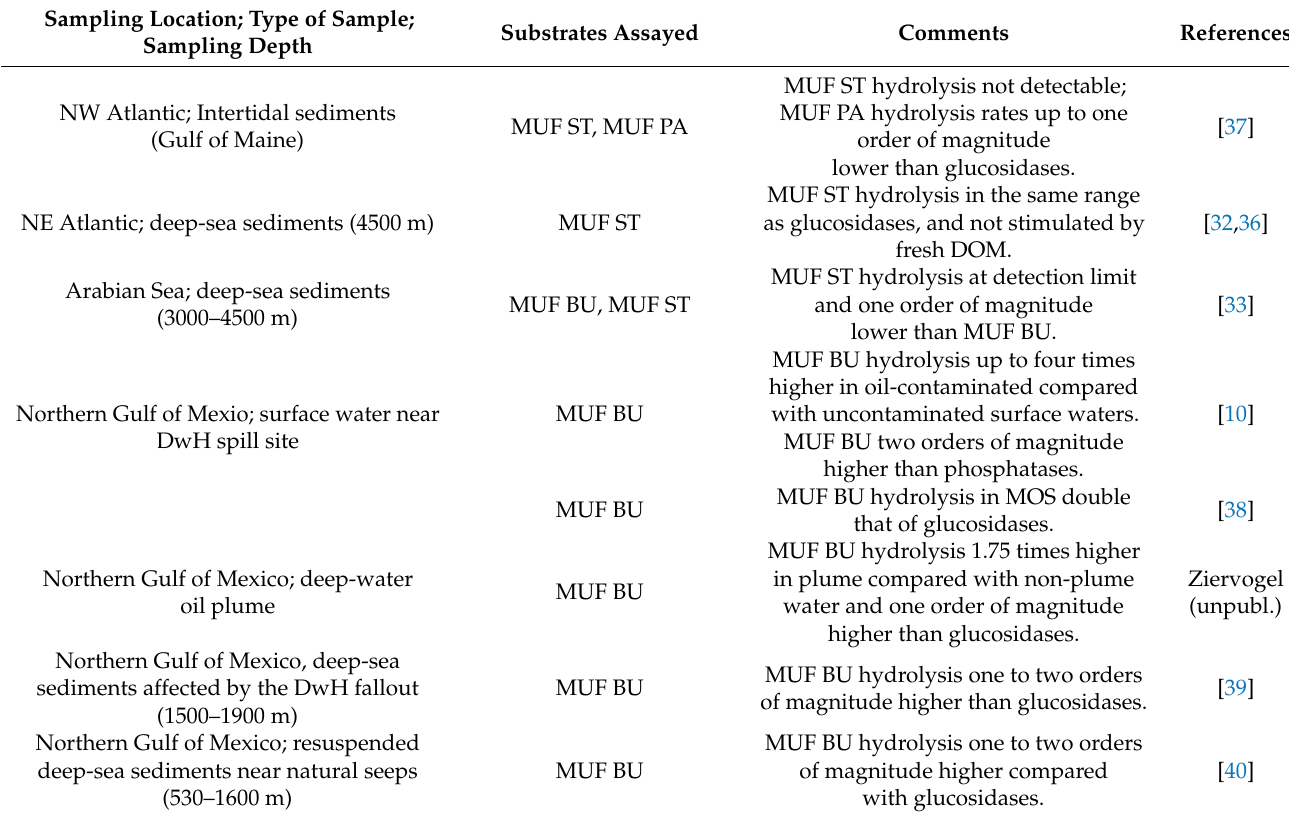
Table 2. Previous published results on esterase activities in the